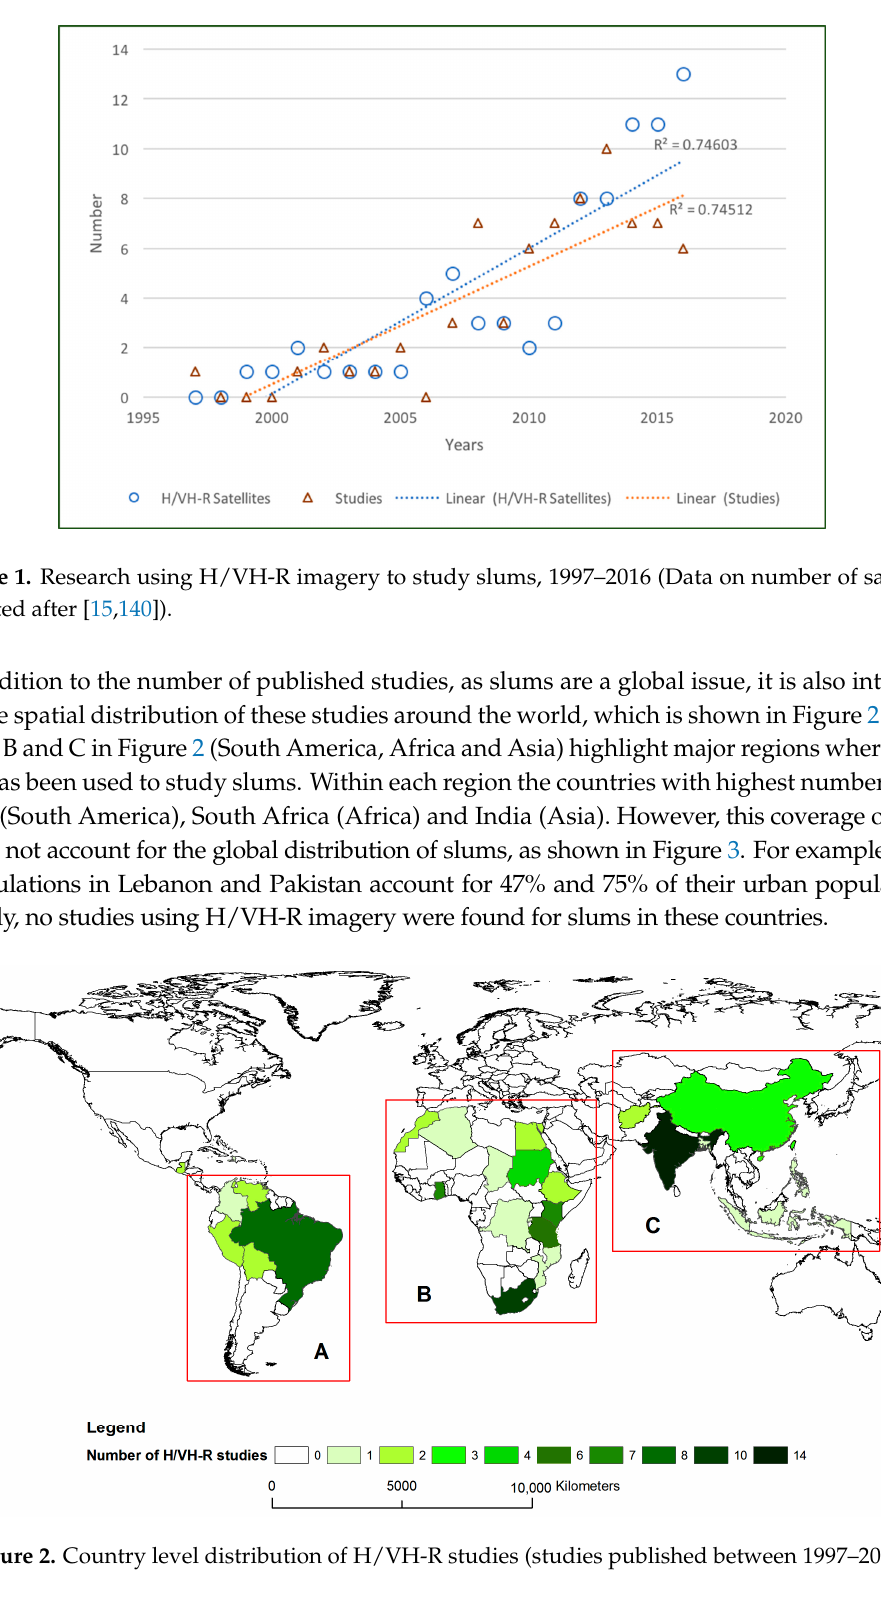
Figure 3. Global distribution of urban and slum populations (Data—Urban Population estimates 2014 [142] and Slum population estimates 2015 [143]).